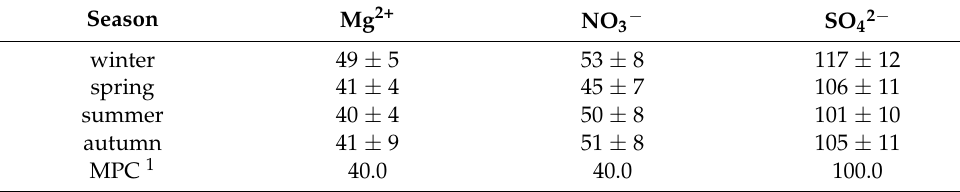
Table 4. The content of some ions in the cultivation water in Laboratory No. 2. Season Mg 2+